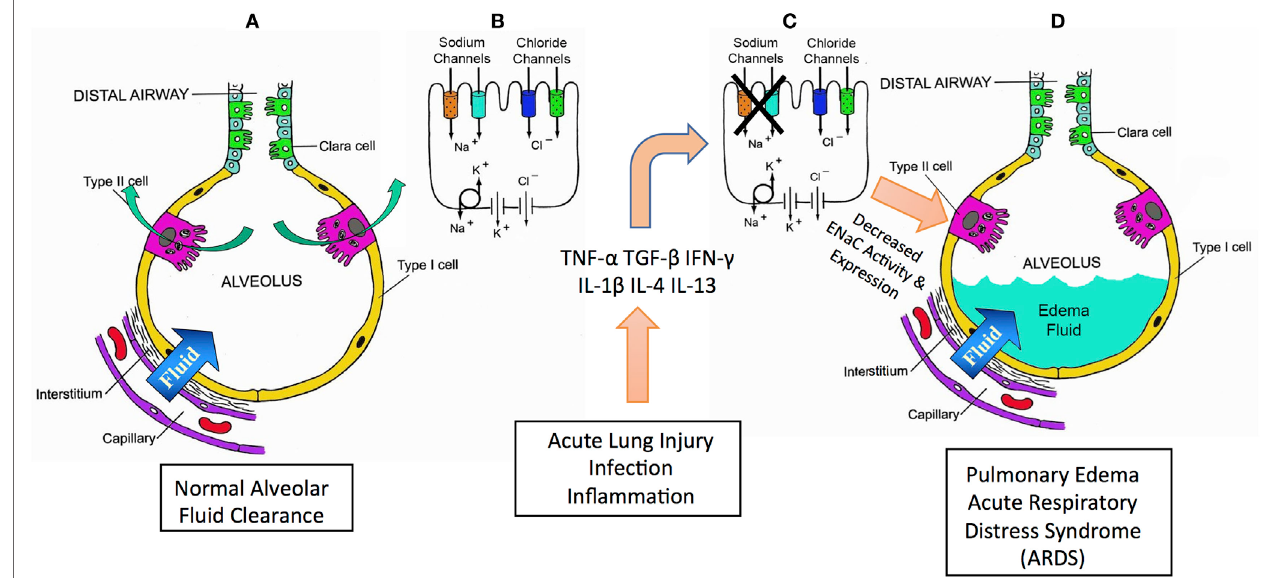
FigURe 1 | Summary schematic for role of cytokines in mediating pulmonary edema and acute respiratory distress syndrome (ARDS). Acute lung injury (ALI), ARDS, and pneumonia are all pathologies characterized by lung edema and alveolar flooding. Pneumonia mortality is typically caused by flooding of the pulmonary alveoli, preventing normal gas exchange and consequent hypoxemia. Airways normally have a critically regulated fluid layer essential for normal gas exchange and removal of foreign particulates from the airway (A) . Maintaining this fluid layer in the alveoli depends critically on sodium reabsorption mediated by epithelial sodium channels (ENaCs) and CFTR chloride channels (B) . During ALI, sepsis, inflammation or infection, inflammatory cytokines are produced that inhibit ENaC (C) . A decrease in ENaC reabsorption allows fluid to accumulate in the alveoli causing alveolar flood in loss of normal gas exchange and consequent hypoxemia (D)